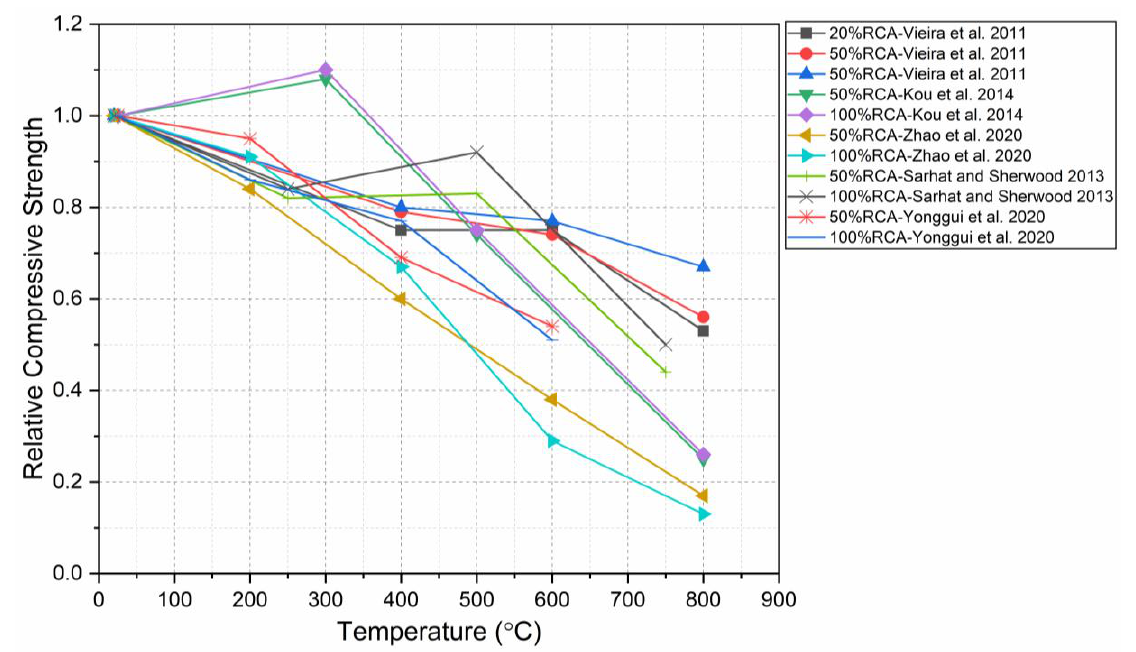
Figure 5. Relative compressive strength of RAC with varying elevated temperature and proportions of RCA [37,60,66,75,79].